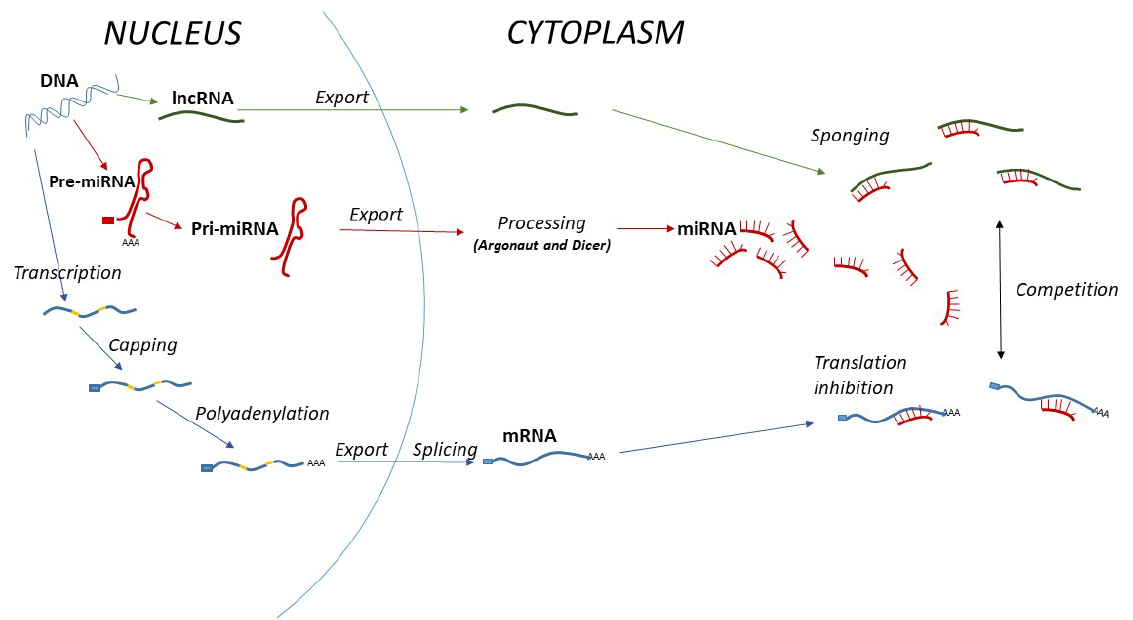
Figure 1. lncRNA–miRNA interaction. Similarly to mRNAs, miRNAs undergo a series of processing steps in the nucleus as well as in the cytoplasm. Some miRNAs can also be produced from their lncRNA precursors. Fully matured mRNAs as well as all non-coding RNAs (such as miRNAs and lncRNAs) are localised in the cytoplasm where lncRNAs and mRNAs compete for miRNAs. This binding can either block or trigger the final translational process and is therefore an important post-transcriptional regulatory step in gene expression.